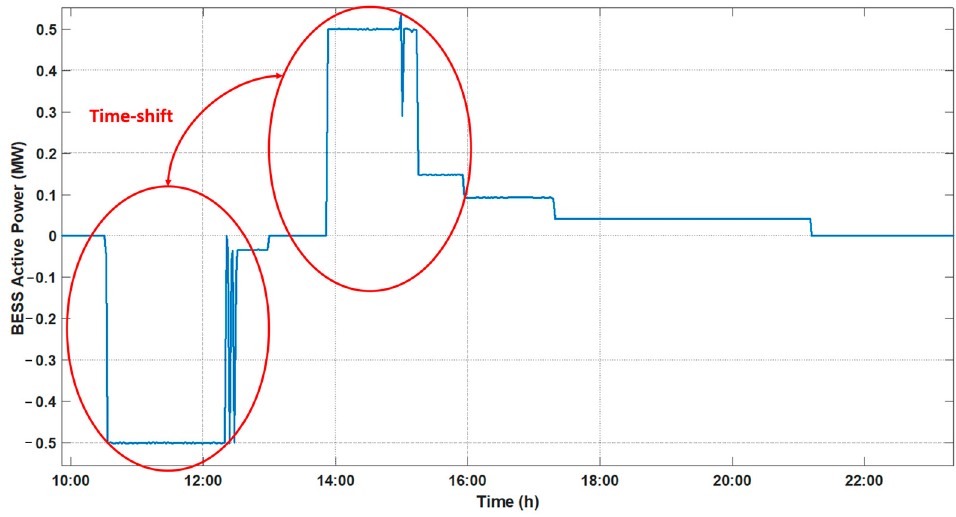
Figure 17. Energy time-shift performed by BESS. Measurement performed on 3 November 2021.